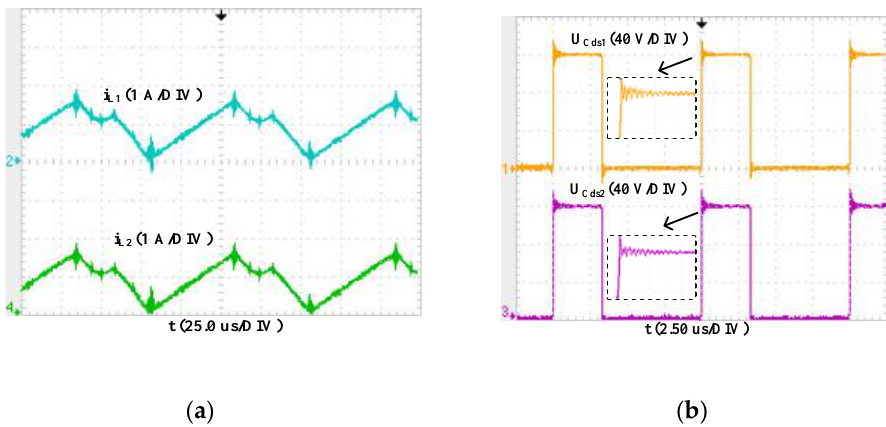
Figure 16. Experimental waveforms considering parasitic parameters for P o = 80 W. ( a ) Inductor current experimental waveform. ( b ) MOSFET voltage ( U Cds ) experimental waveform.